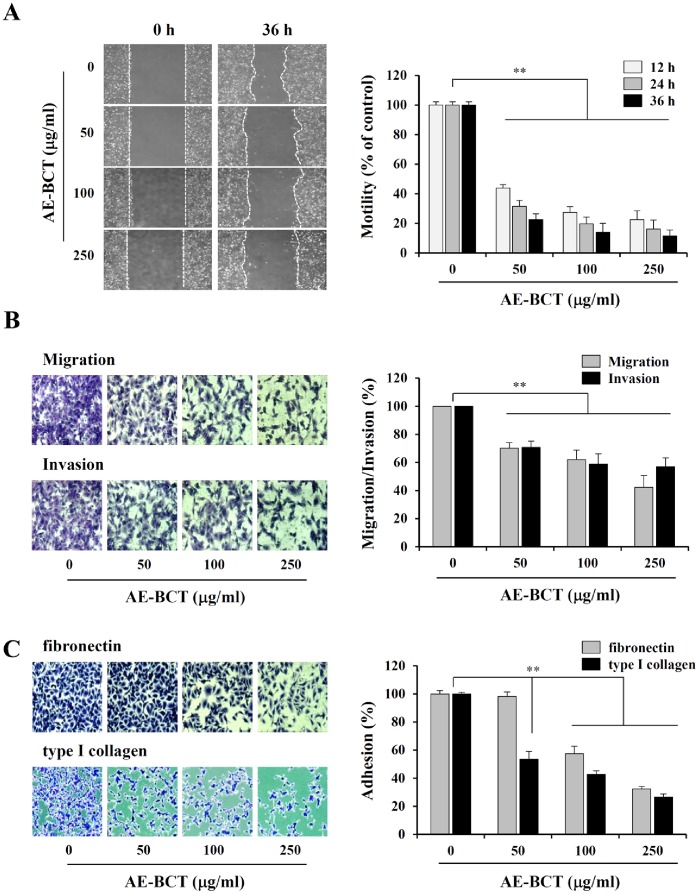
Effect of AE-BCT on the in vitro migration, invasion, and adhesion to ECM of HT1080 cells.(A) Confluent cell monolayers were treated with mitomycin C (25 µg/mL) for 1 h and an injury line was drawn. Cell debris was removed by washing and the cells were incubated in medium containing 10% FBS with or without 50, 100, or 250 µg/mL AE-BCT. Wound migration was monitored using a phase-contrast microscope (×40) at the indicated time points and the relative width of the gap region was quantified by measuring four selected fields. (B) Cells pre-incubated for 12 h with or without AE-BCT were harvested and suspended in serum-free DMEM at a density of 1×106 cells/mL. After filling the upper Transwell chamber with cells suspended in serum-free DMEM (1×105 cells/100 µL) and the lower chamber with 10% FBS/DMEM (650 µL), the cells were incubated. Cells that migrated and invaded to the lower surface of the membrane were stained and observed using a phase-contrast microscope. (C) Cells pre-incubated for 12 h with or without AE-BCT were harvested and suspended in serum-free DMEM at a density of 5×105 cells/mL. After seeding on FN- or collagen-coated wells (1×105 cells/well/200 µL), cells were incubated for 1 h and then washed to remove unattached cells. Attached cells were quantified by crystal violet staining. The relative degrees of migration, invasion, and adhesion to ECM were quantified using ImageJ. Data are expressed as means ± SD of three independent experiments. **p<0.01 vs untreated control.